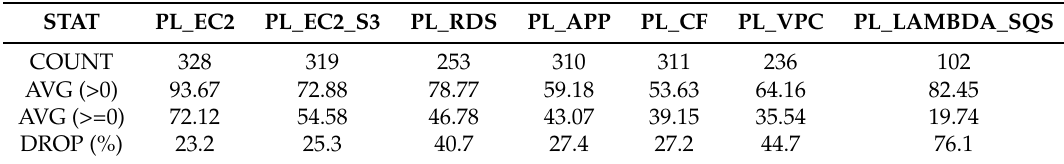
Table 2. Statistical overview of the students’ results for the lab activities in the cloud across three academic years ( N = 427).